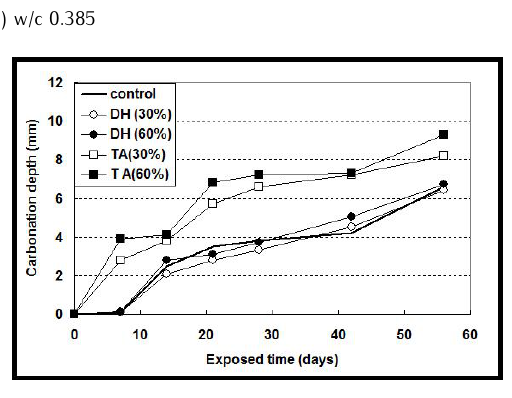
Figure 12. Migration coefficient in PA mortar with HWRA.